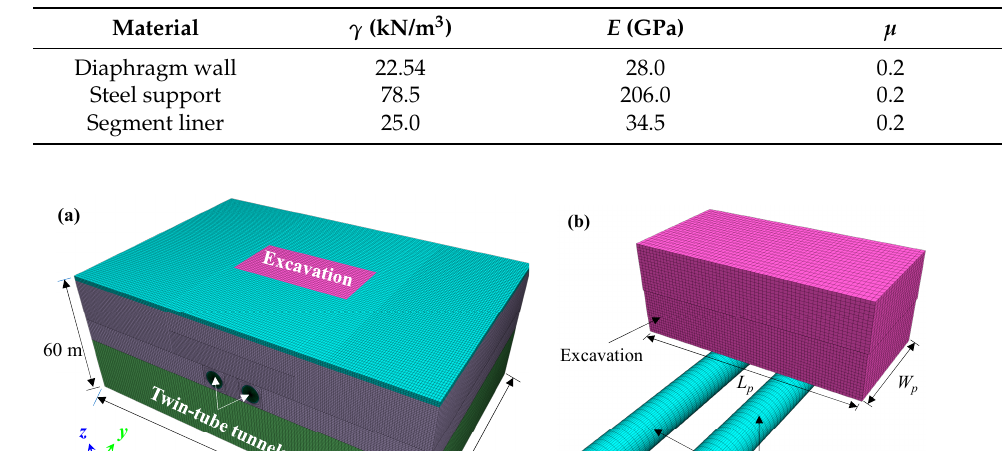
Table 4. Material parameters of supporting structures.